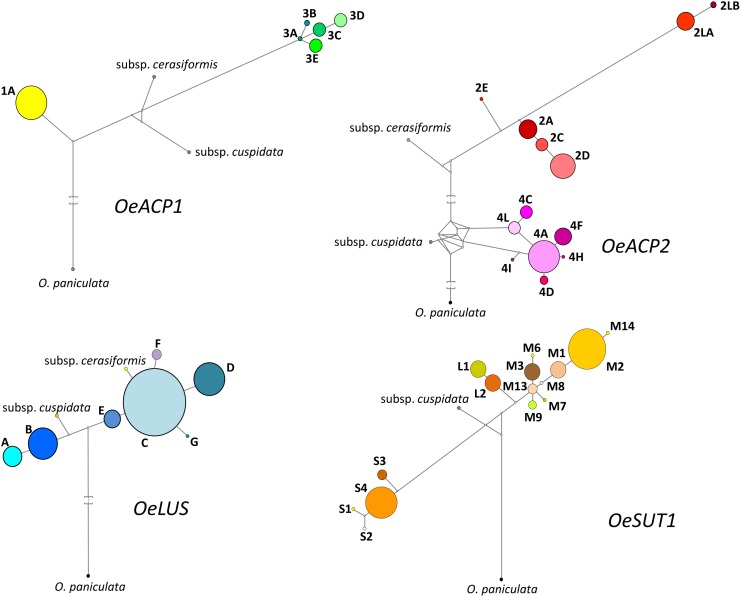
Most parsimonious networks obtained by Network 4.6.11 using SNPs and length polymorphisms for each allele at the four loci. Each haplotype is represented by a colored circle, whose size is related to the frequency within the 90 olive cultivars dataset. Branch length is proportional to the number of mutations. Median vectors (white nodes) correspond to possible extant unsampled or extinct ancestral sequences.